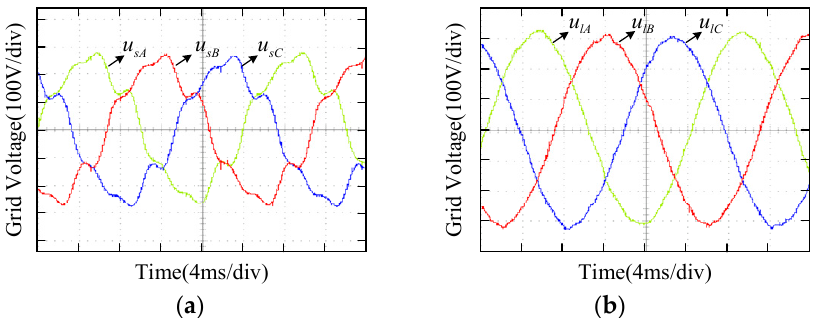
Figure 16. Temporary sag and harmonic conditions. ( a ) Grid voltage before compensation; ( b ) load voltage after compensation.